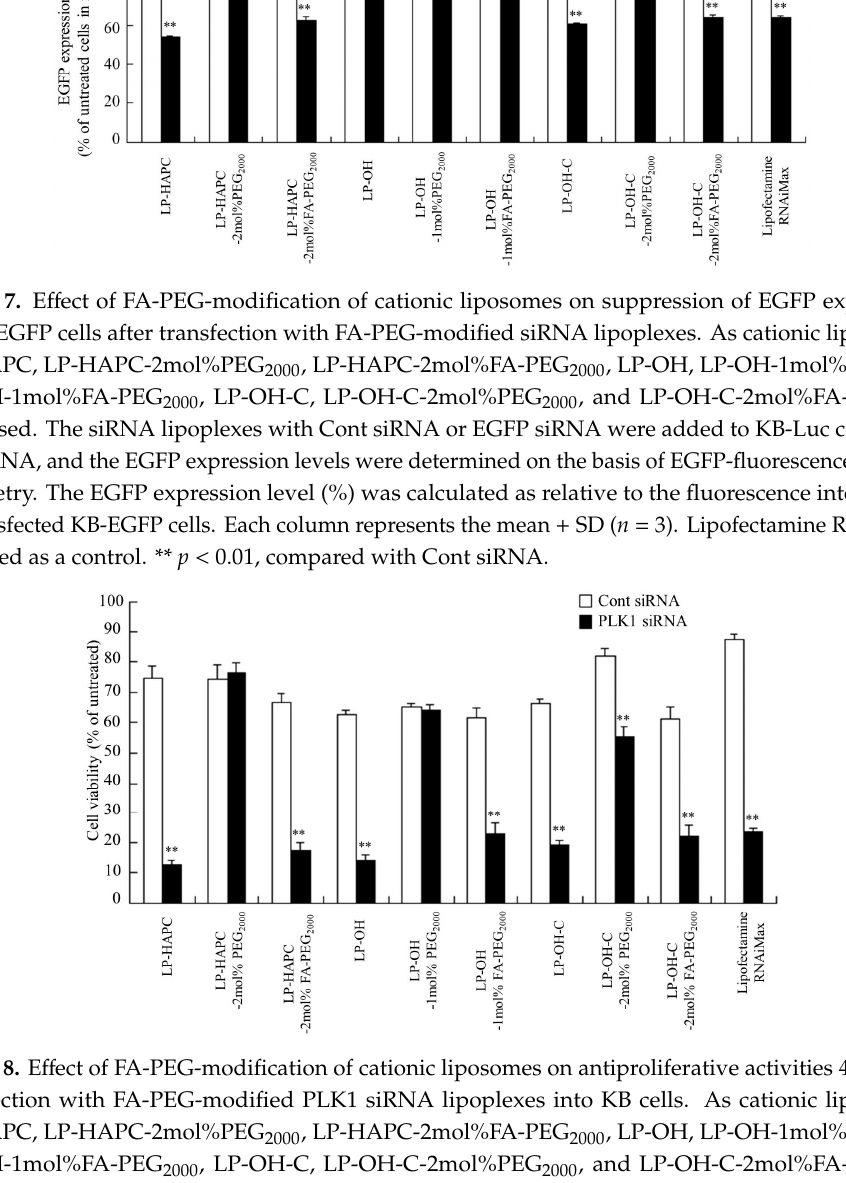
Figure 7. Effect of FA-PEG-modification of cationic liposomes on suppression of EGFP expression in KB-EGFP cells after transfection with FA-PEG-modified siRNA lipoplexes. As cationic liposomes, LP-HAPC, LP-HAPC-2mol%PEG 2000 , LP-HAPC-2mol%FA-PEG 2000 , LP-OH, LP-OH-1mol%PEG 2000 ,